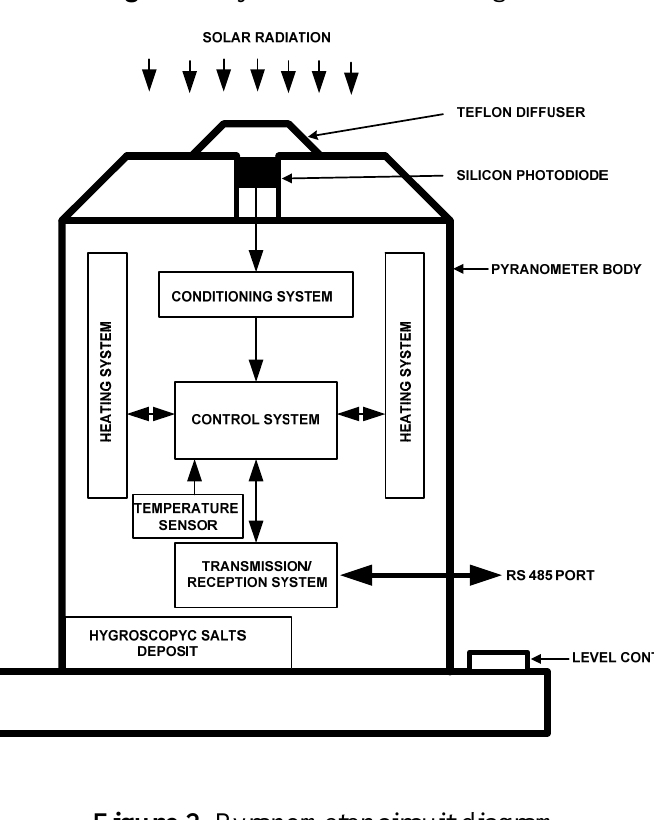
Figure 1. Pyranometer block diagram.